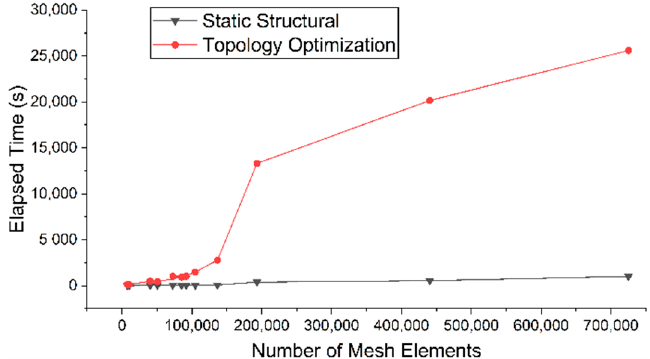
Figure 18. Elapsed time of simulation in increased mesh elements.